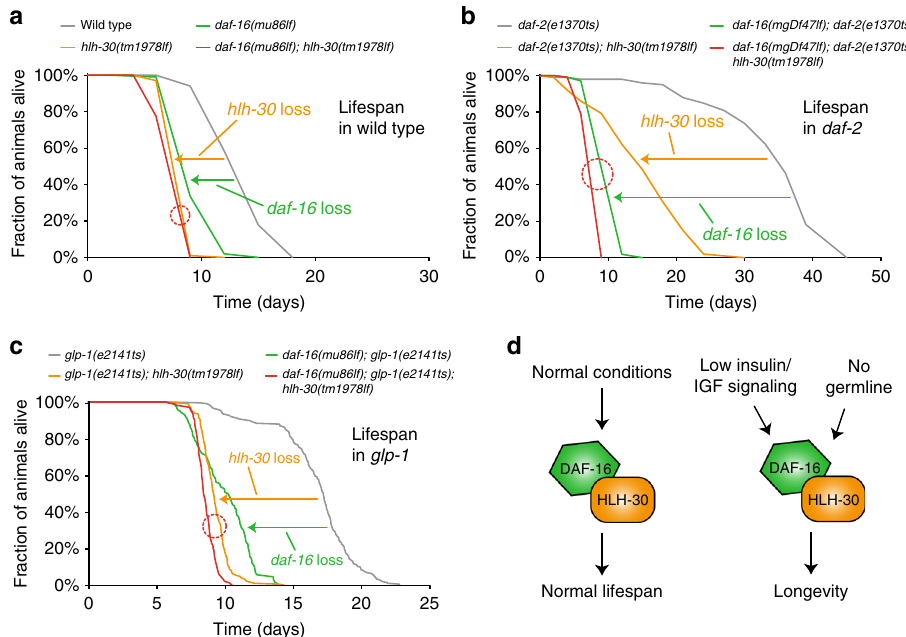
Fig. 3 DAF-16/FOXO and HLH-30/TFEB require each other to promote longevity. Lifespan phenotypes caused by loss of daf-16 and/or hlh-30 in various genetic backgrounds. Red circles indicate the largely absent additive effects caused by joint loss of both transcription factors. a , b Animals of indicated genotypes were grown from the L1 stage at 15 °C and then shifted to 25 °C at the L4 stage and their lifespan was monitored. ( n ≥ 98; for detailed statistics including log-rank tests see Supplementary Table 2.) c Animals of the indicated genotypes were grown from the L1 stage at 25 °C and their lifespan was monitored. ( n ≥ 173; for detailed statistics including log-rank tests see Supplementary Table 2.) d Models illustrating the genetic interaction between daf-16 and hlh-30 for the promotion of normal lifespan and